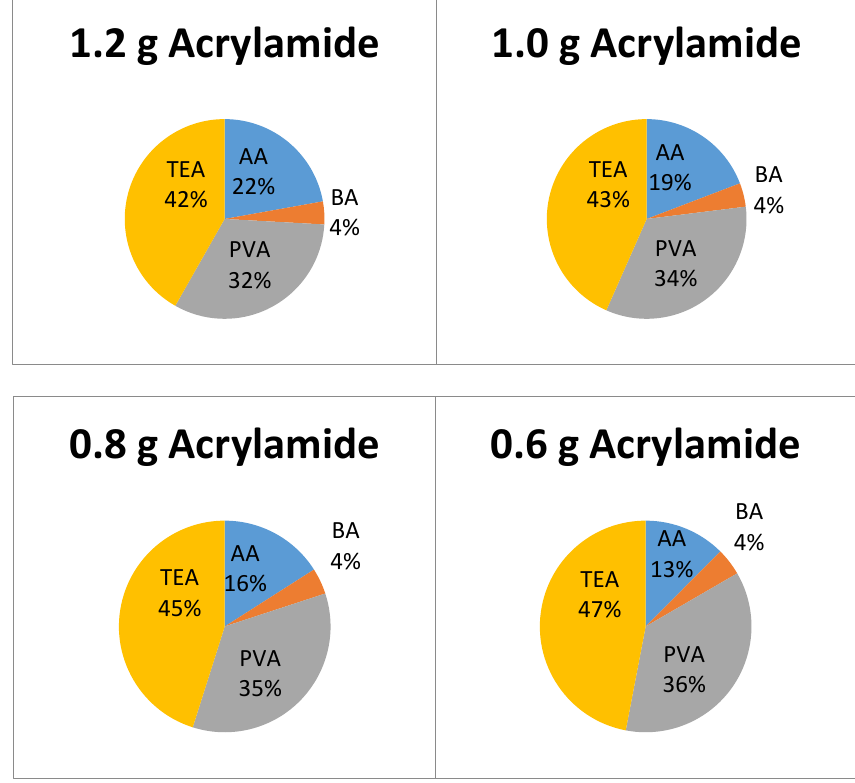
Figure 3. Mass ratios of photopolymer with varying acrylamide concentration. AA—acrylamide, BA-N,N’—Methylenebisacrylamide, TEA—Triethanolamine, PVA—Polyvinylalcohol.